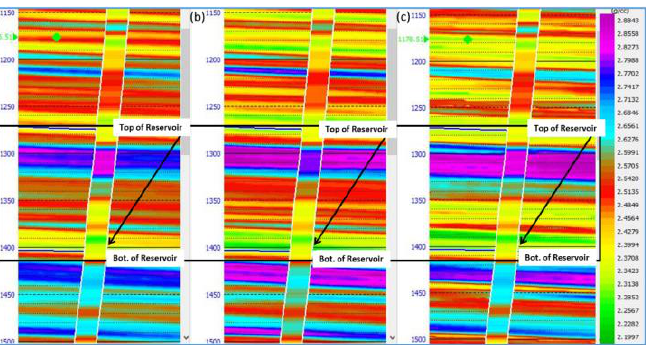
Figure 8. A subline over the predicted seismic density volume with the actual density log of the intersected well ( a ) 13 wells used to train and validate the data; ( b ) 6 wells used to train and validate the data, and ( c ) 6 wells with the machine learning approach. The black rectangle encloses the res- ervoir interval, and the black arrow indicates the resolution differences between the different paths. We used the six-well trained nonlinear regression approach to predict porosity using seismic volume with predicted density and compared it to DV velocity variations between baseline and monitor surveys and 4D seismic inversion of P impedance. It clearly showed that we had a negative DV with a lower P-impedance at the reservoir level, reflecting a lower density and a higher porosity of almost 14%, which is quite close to the average total porosity of 15 PU from the Petro-elastic model mentioned earlier (Figure 9). To un- derstand the seismic response of a reservoir whose acoustic impedance (density × veloc- ity) is lower than that of the trapped gas, it is necessary to understand that velocity and density increase as the water replaces the oil, resulting in acoustic hardening. However, in this study, it was found that gas replaces oil when velocity and density decrease. This leads to acoustic softening, which leads to an increase in seismic amplitude and a down- ward time shift [32].